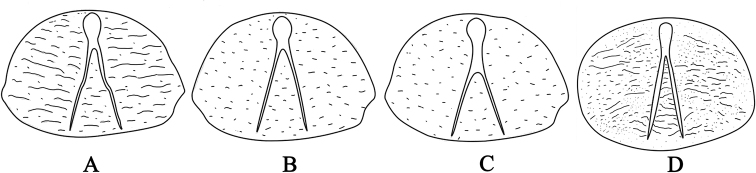
Larval pronotal plate of Chalcophora species (A–C from Bílý 1984) AC.
detritaBC.
marianaCC.
intermediaDC.
japonica
chinensis.